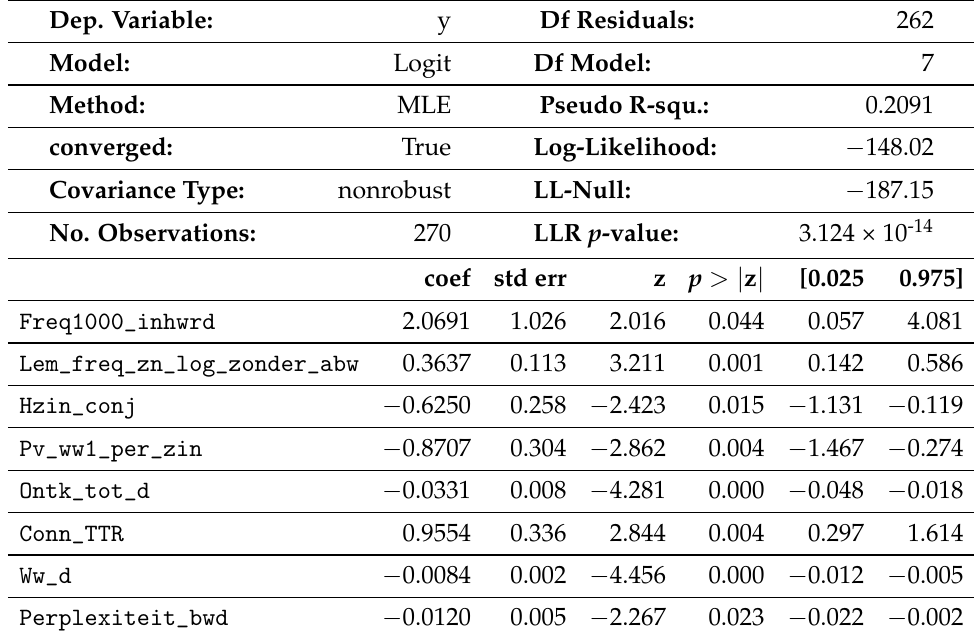
Table 3. Logistic regression results, balanced with